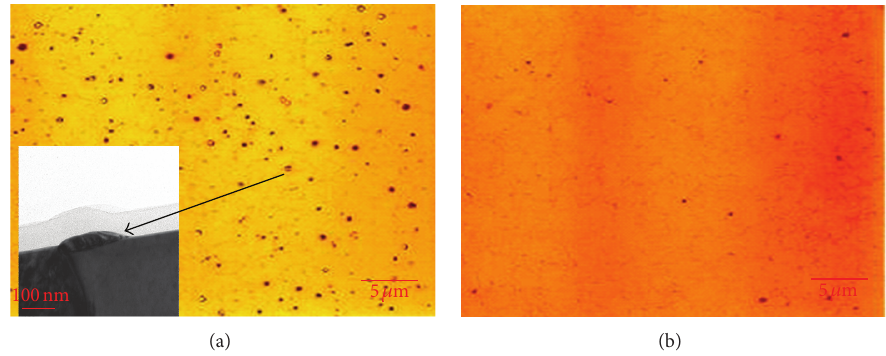
Figure 8: OM images of Cu hillocks (a) 30 s H 2 plasma treatment; (b) 30s NH 3 plasma treatment.